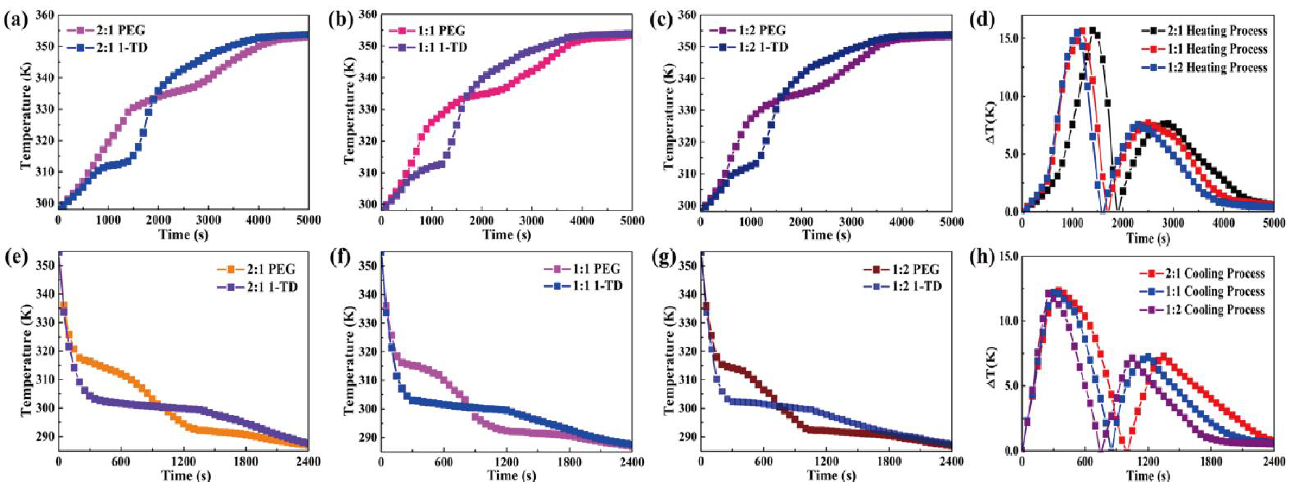
Figure 8. Temperature profiles during heating for ( a ) 2:1 ratio PEG and 1-TD composites, ( b ) 1:1 ratio PEG and 1-TD composites and ( c ) 1:2 ratio PEG and 1-TD composites. ( d ) Resulting temperature differences. Cooling cycle of ( e ) 2:1 ratio PEG and 1-TD composites, ( f ) 1:1 ratio PEG and 1-TD composites and ( g ) 1:2 ratio PEG and 1-TD composites. ( h ) Resulting temperature differences.